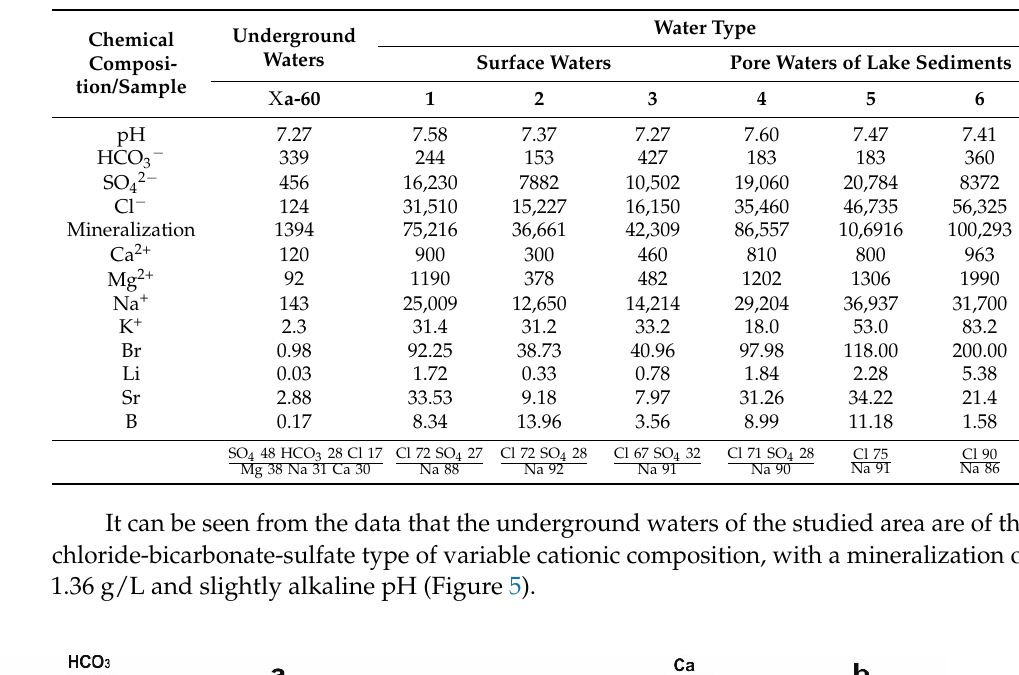
Table 2. Chemical composition of Lake Taloe Basin waters and underground waters of the area, mg/L.